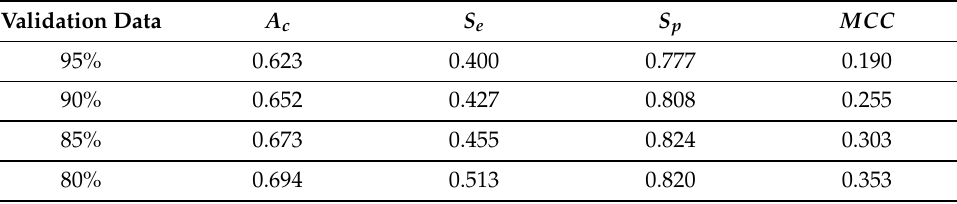
Table 7. NF and WF signal classification results obtained from SVM G applying real-parts of Mam- moWave’s complex S 21